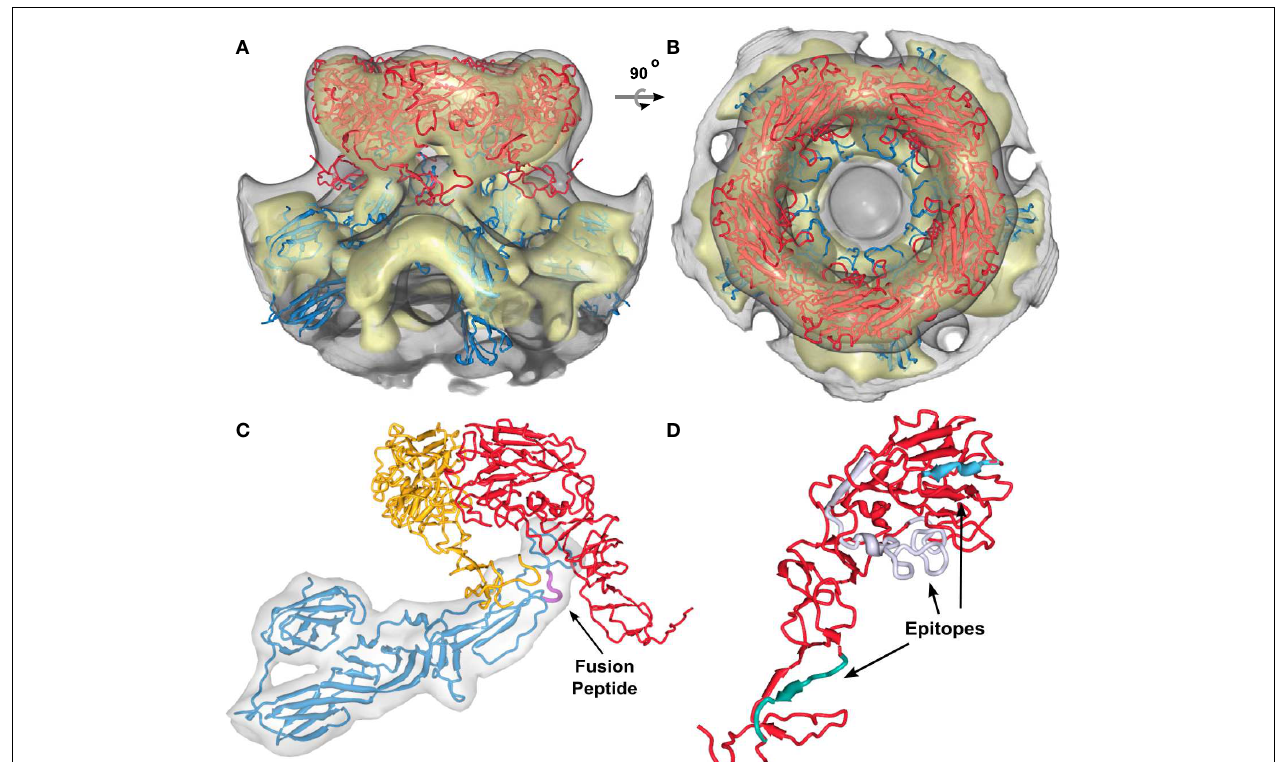
heterodimer) and an adjacent Gn monomer have been extracted from the docking results shown in (A) .Within the basic structural unit, the head domain of the Gn model (red and yellow) covers domain II of Gc.The predicted location of the fusion peptide shown in domain II of Gc is highlighted in magenta and indicated by the black arrow. (D) Epitopes for three monoclonal antibodies recognizing Gn (Keegan and Collett, 1986) are highlighted.These epitopes are corresponding to the monoclonal antibodies 4-32-8D (gray), 4-D4 (blue), and 3C-10